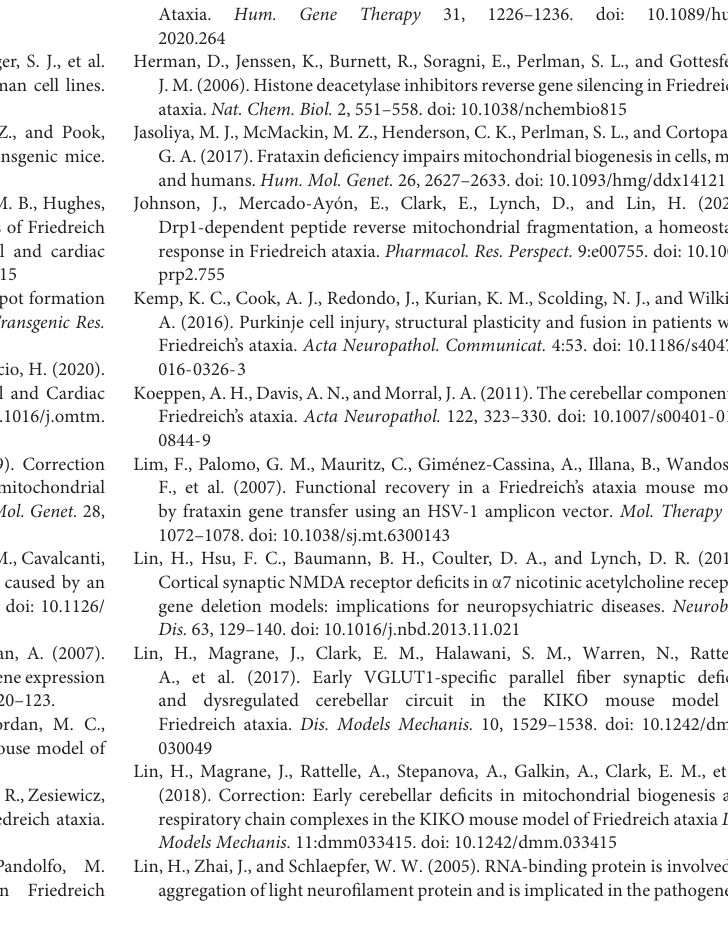
Supplementary Figure 1 | Time-course of frataxin knockdown in CNS and peripheral tissue of FRDAkd mice at 4, 8–12, and 18 weeks of induction.